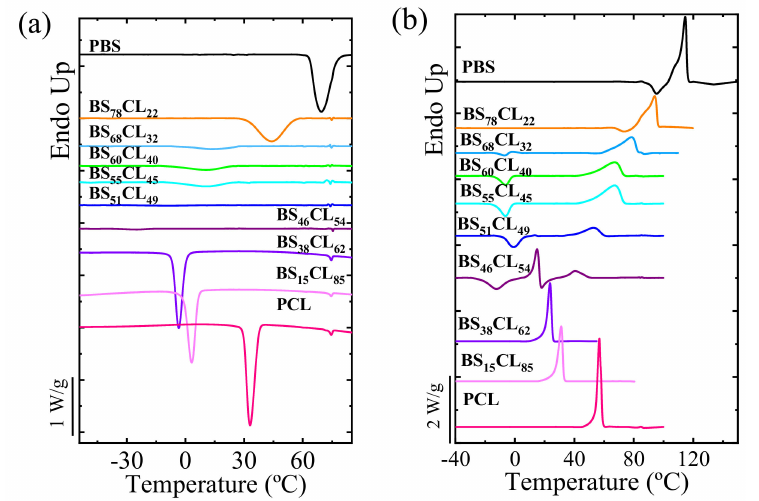
Figure 3. DSC cooling ( a ) and second heating ( b ) runs at a rate of 10 ◦ C/min for the HM W -BS x CL y copolyesters.